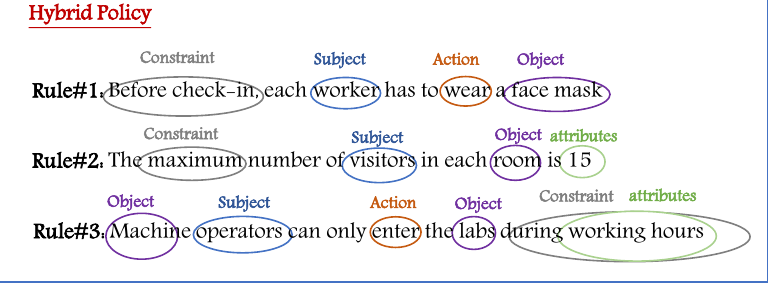
Figure 16. An example of hybrid policy.